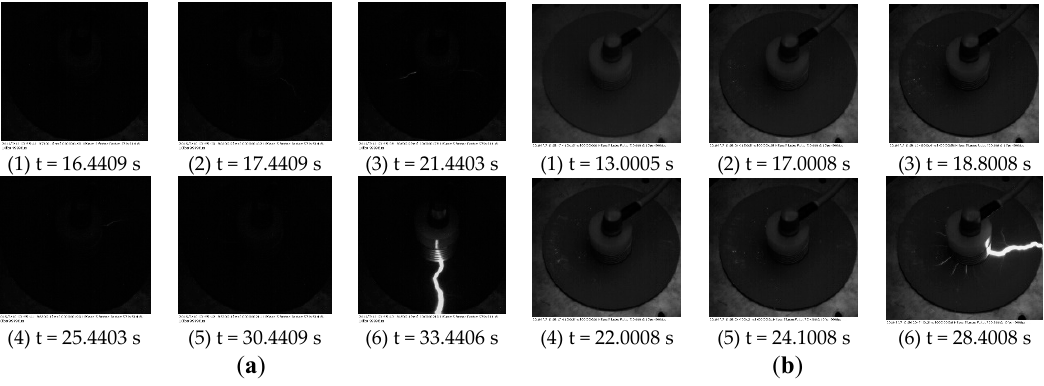
Figure 20. Flashover development ( a ) Clean RTV coating, 50% relative humidity. ( b ) Simulated haze-fog environment, 90% relative humidity.